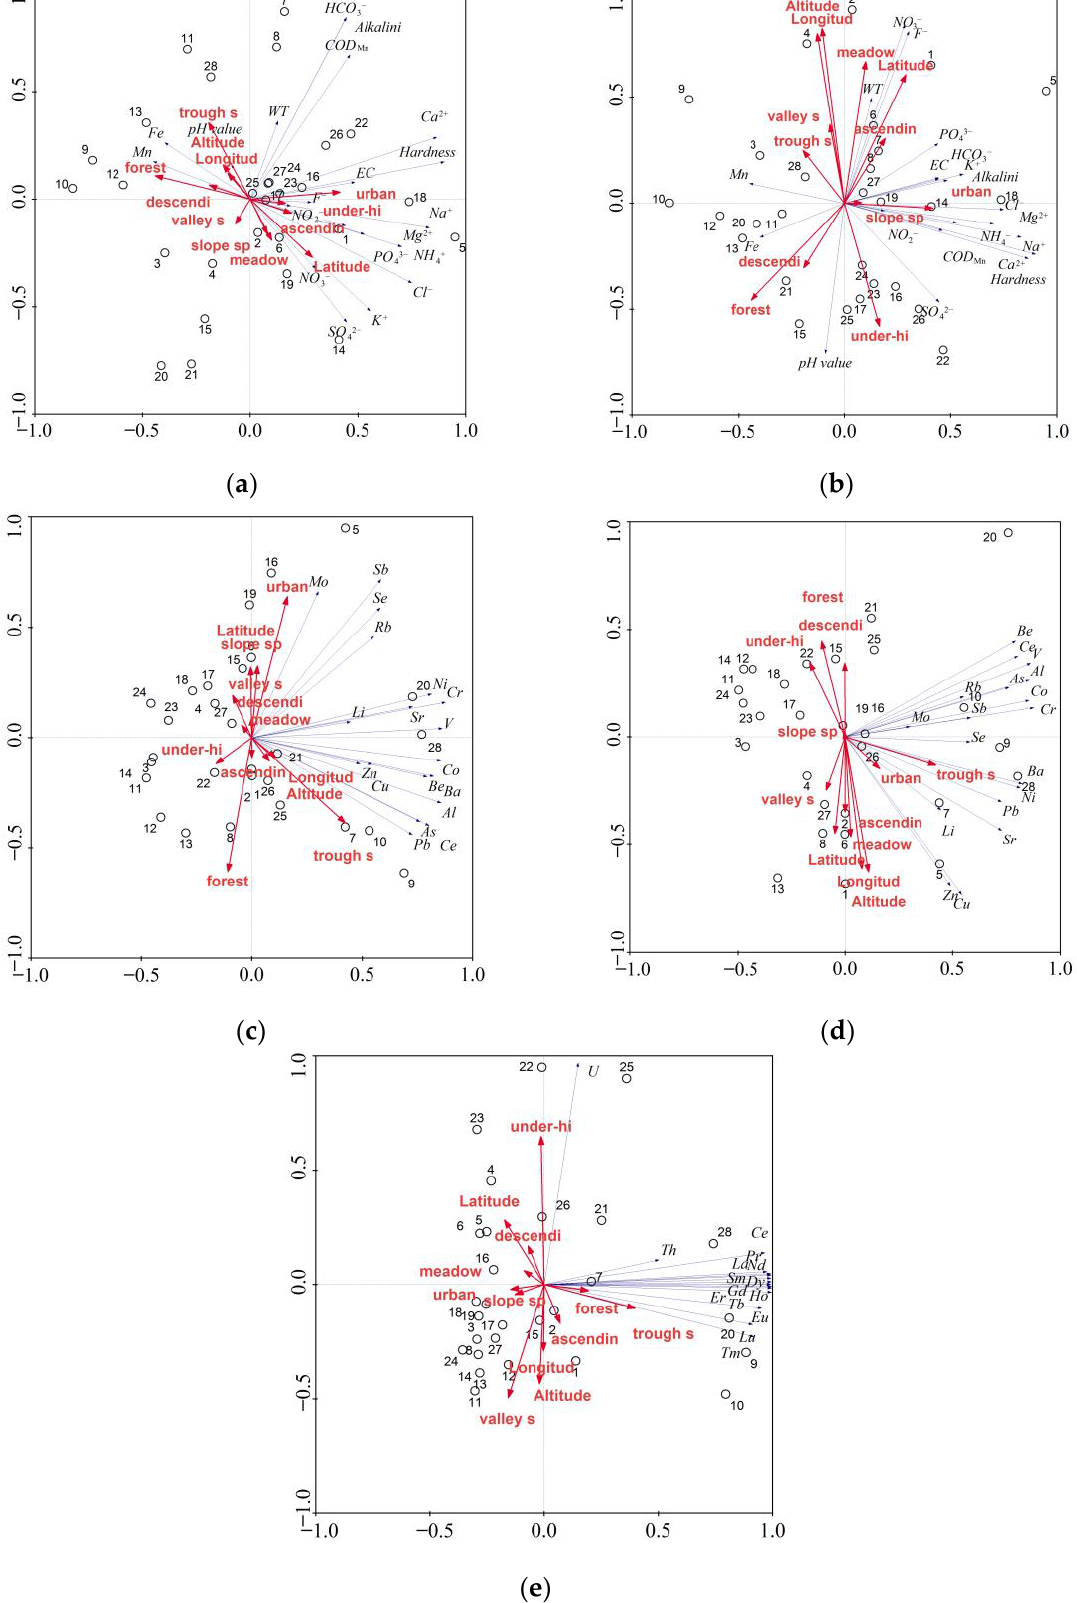
Figure 5. Results of PCA analysis in reference to: ( a ) MEs — PCA1 vs. PCA2; ( b ) MEs — PCA1 vs. PCA3; ( c ) TEs — PCA1 vs. PCA2; ( d ) TEs — PCA1 vs. PCA3; ( e ) REEs — PCA1 vs. PCA2.